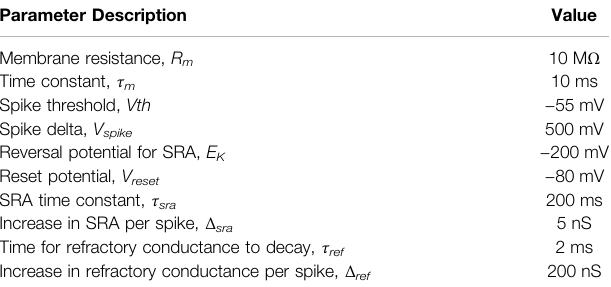
TABLE 1 | Integrate-and- fi re converter (IFC) parameters. Parameter